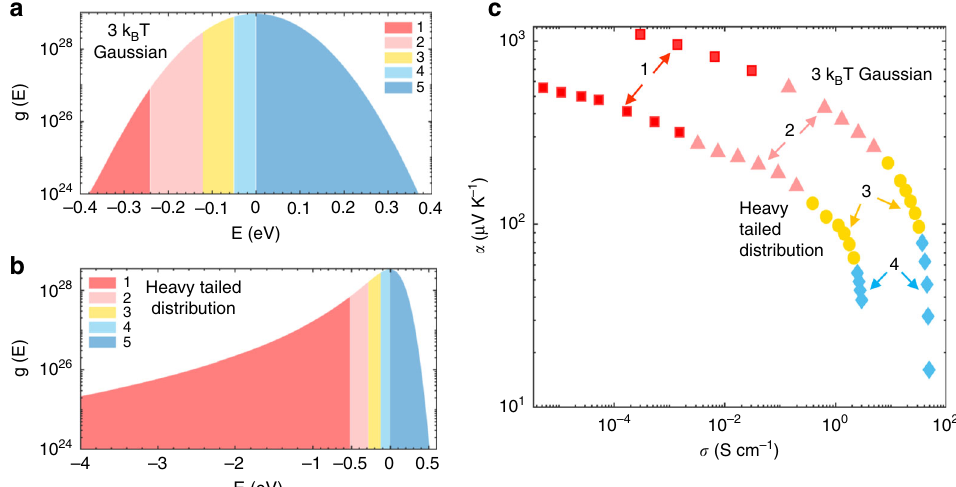
Fig. 7 Impact of density of states distribution on Seebeck coef fi cient vs. conductivity curve. Schematic showing the fi lling up of the a Gaussian and b heavy- tailed density of states DOS with increasing doping, by varying the Fermi level E F further and closer to the center of the energy distribution and c the corresponding effect on the log-log plot of Seebeck coef fi cient vs.